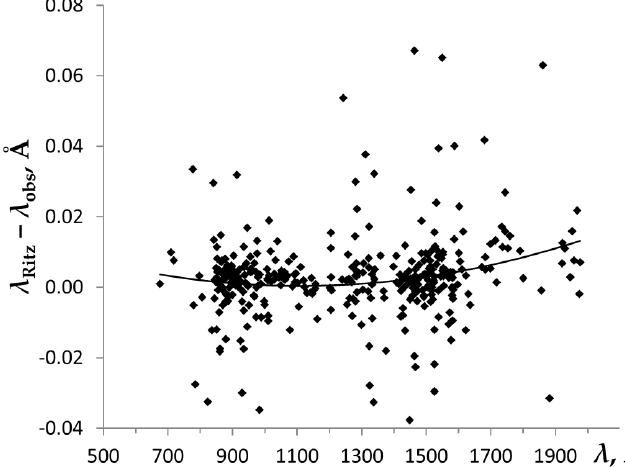
Figure 3. Deviations of vacuum ultraviolet (VUV) wavelengths measured by Shenstone [1] from Ritz values from Ross [2]. The solid line is a 2nd degree polynomial fit.